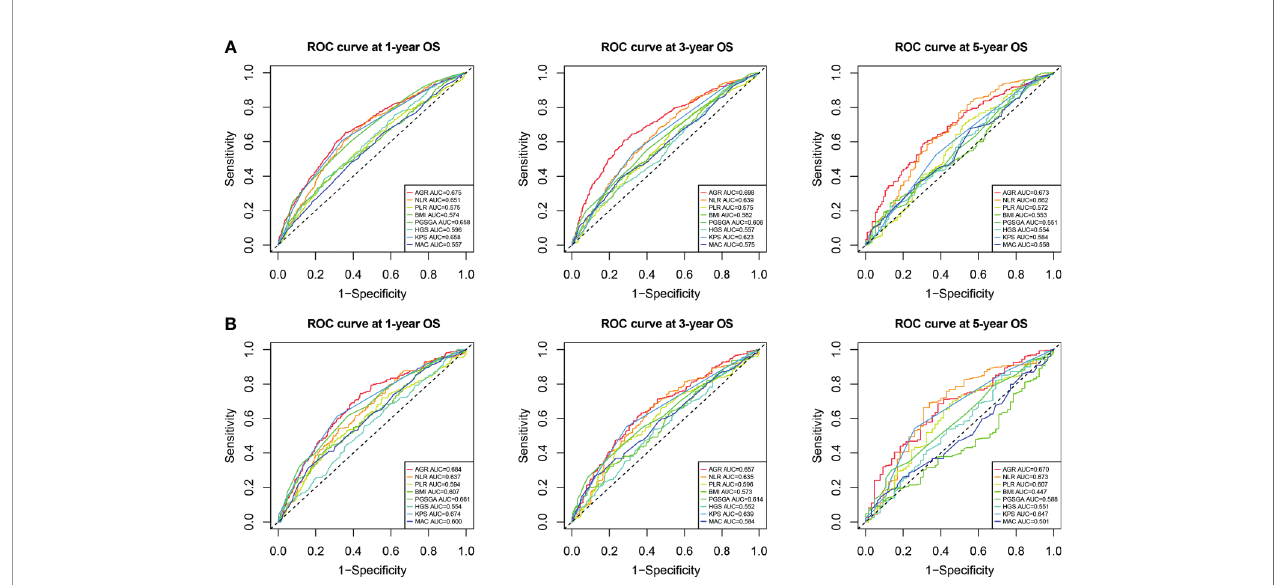
FIGURE 4 | Comparison of the ability of malnutrition evaluation tools in predicting prognosis of cachexia patients using ROC curves. (A) ROC curve at 1-, 3-, and 5-year OS points in training cohort. (B) ROC curve at 1-, 3-, and 5-year OS points in validation cohort. ROC, receiver operating characteristic; OS, overall